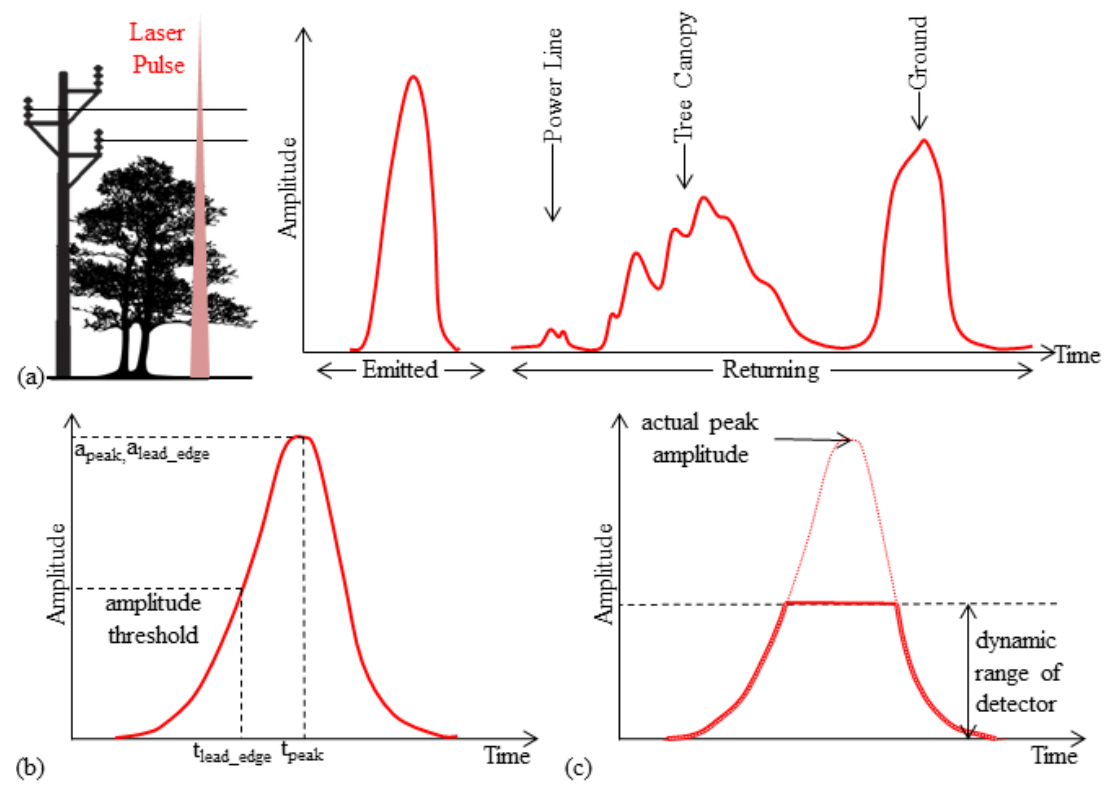
Figure 1. ( a ) Example of the shape of a waveform emitted and returned; ( b ) point selection on the return waveform in the peak detection and leading edge detection methods; ( c ) saturation impact resulting from highly reflective objects close to the scanner, exceeding detection